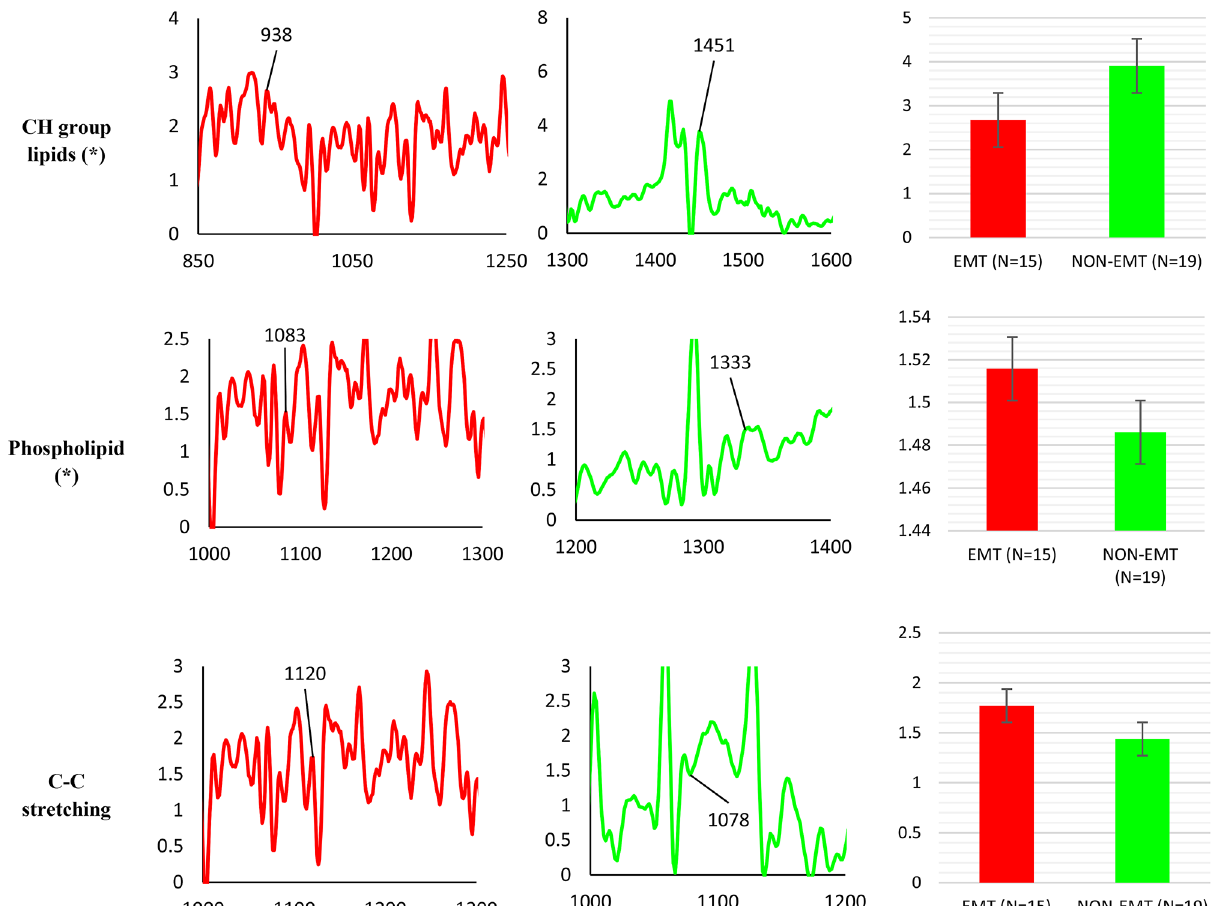
Figure 5. Summary of lipid vibrational bands observed for waxed samples (Group 2) in EMT and non-EMT breast cancer tissue. The x- and y-axes represents the wavenumber and normalised (vector normalisation) intensity respectively. The black colour represents the non-lesional tissues, while red represents EMT tissues and green represents non-EMT tissues. Comparison of the relative intensity of lipid Raman bands in waxed samples between EMT and non-EMT breast tissue samples is depicted in the bar charts. Each column represents the average of spectra for each type of tissue. The value of N represents the number of Raman spectra acquired for each sample, shown within the brackets. The error bar represents standard deviation. Note: the x-axis represents the tissue type and y-axis is Raman intensity. (*) denotes a statistically significant difference between the groups reported by the